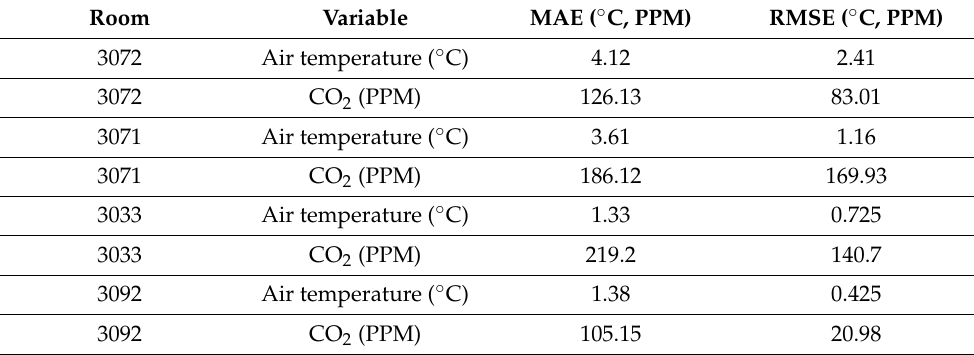
Table 2. Calibration results for three rooms of the Helios building for the period January–March